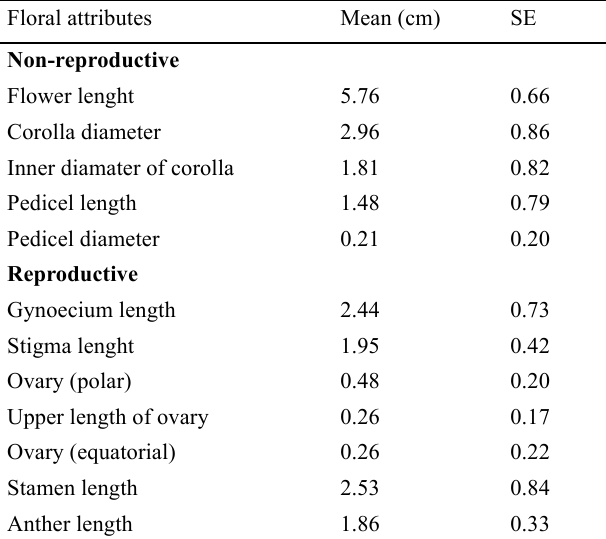
Table 1. Floral attributes of Martynia annua in the studied location. SE = standard error.